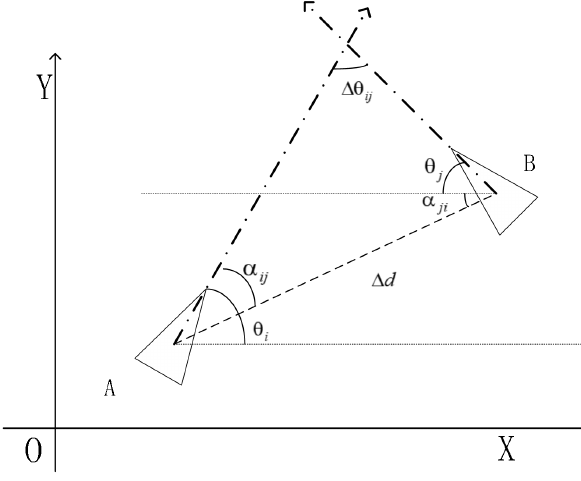
Figure 2. Schematic diagram illustrating the relative observation between two